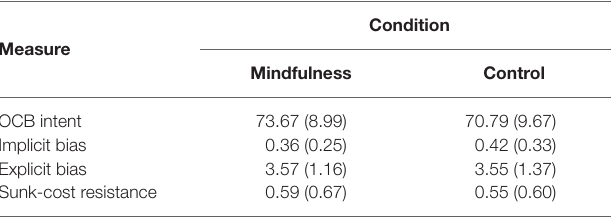
TABLE 3 | Descriptive statistics for dependent variables by